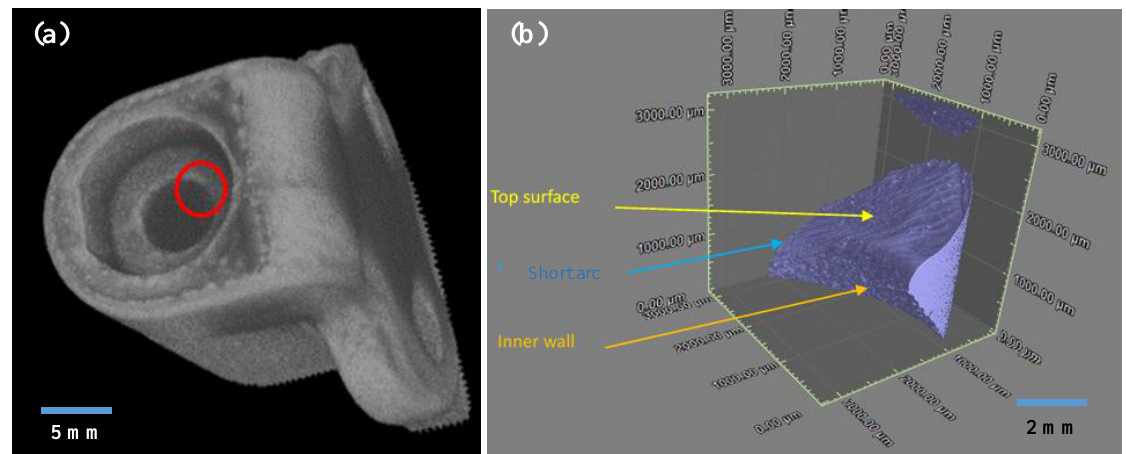
Figure 7. ( a ) Three-dimensional view of the AM-fabricated sample with a relatively complex geometry; ( b ) 3D view of the small region near the inner circle profile (red circle in 7a) further observed under high resolution.